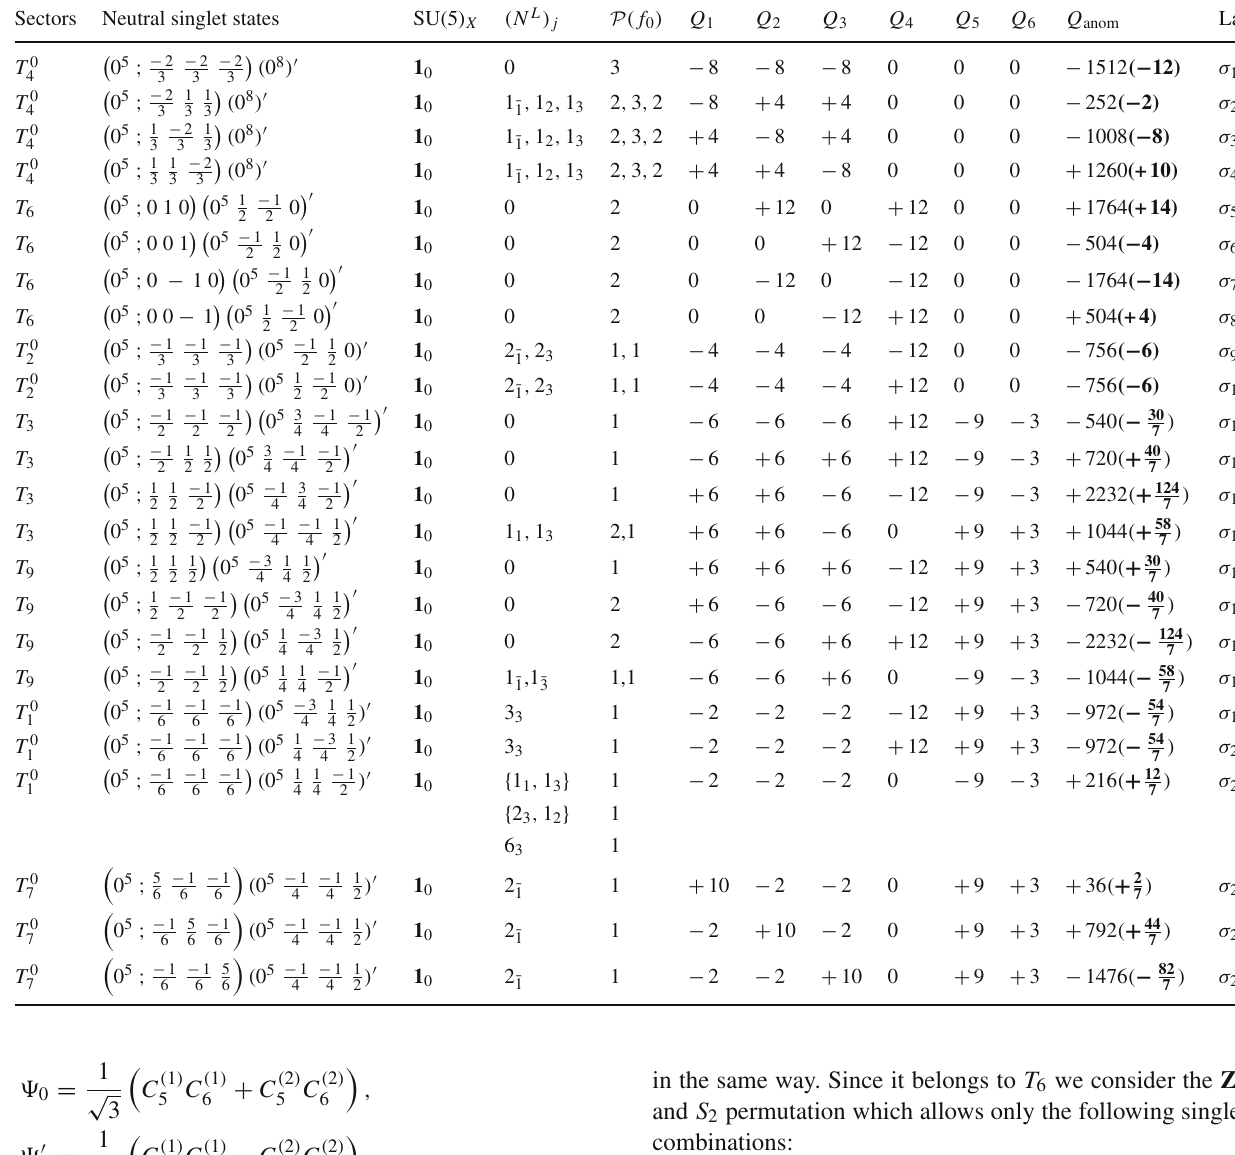
Table 2 Left-handed SU ( 5 ) × U ( 1 ) X × SU(5) (cid:2) × SU(2) (cid:2) singlet states. ( N L ) j is the notation for the oscillator mode of the oscillating string with j denoting the coordinate in the internal space. P ( f 0 , + , − ) is